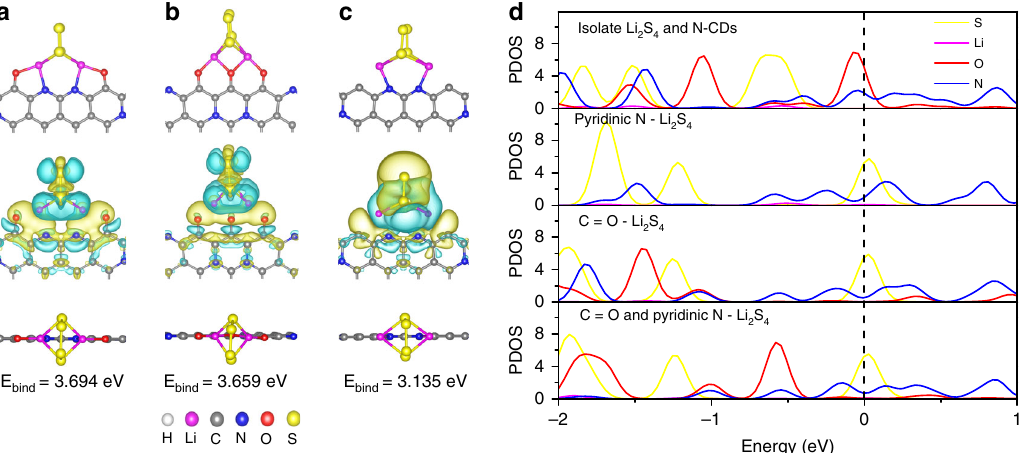
Fig. 7 Optimized structures, charge transfers, binding energies, and atomic partial density Li 2 S 4 absorbed at different sites. a C = O and pyridinic N site. b C = O site. c pyridinic N site. Here, yellow (blue) is the spatial region gain (loss) in charge. d Atomic partial density of states near the Fermi energy region for isolate Li 2 S 4 and N-CDs, Li 2 S 4 absorbed at pyridinic N and C = O sites, respectively, and Li 2 S 4 absorbed at C = O sites and pyridinic N sites simultaneously.